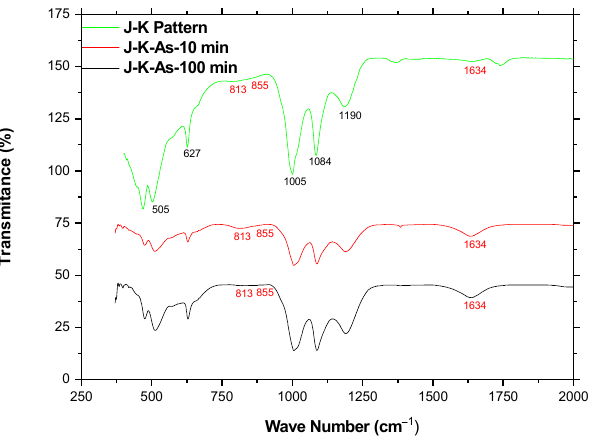
Figure 7. FTIR spectra of the potassium jarosite with As(V) compared to spectrum for J-K pattern.